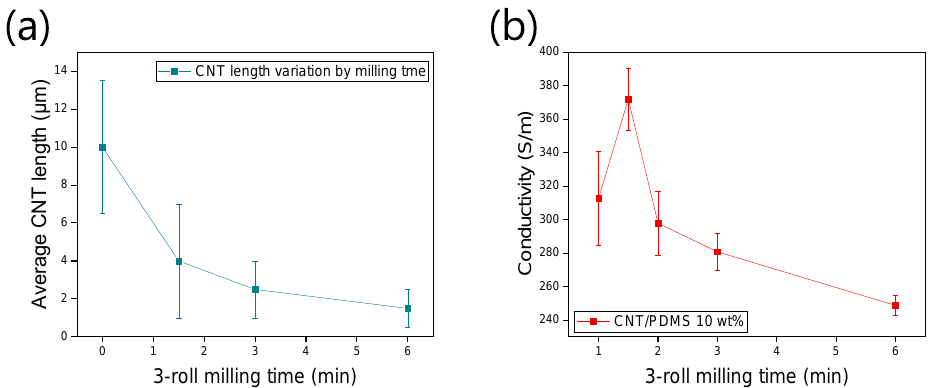
Figure 6. ( a ) Changes in CNT length with increasing three-roll milling time. ( b ) Electrical conductivity of CNT composite films obtained by milling for various times. The increase in electrical conductivity as the milling time increases from 1 to 1.5 min is due to the greater dispersion stability. After 1.5 min of milling time, the conductivity decreases because the decrease in CNT length reduces the number of CNT contacts.